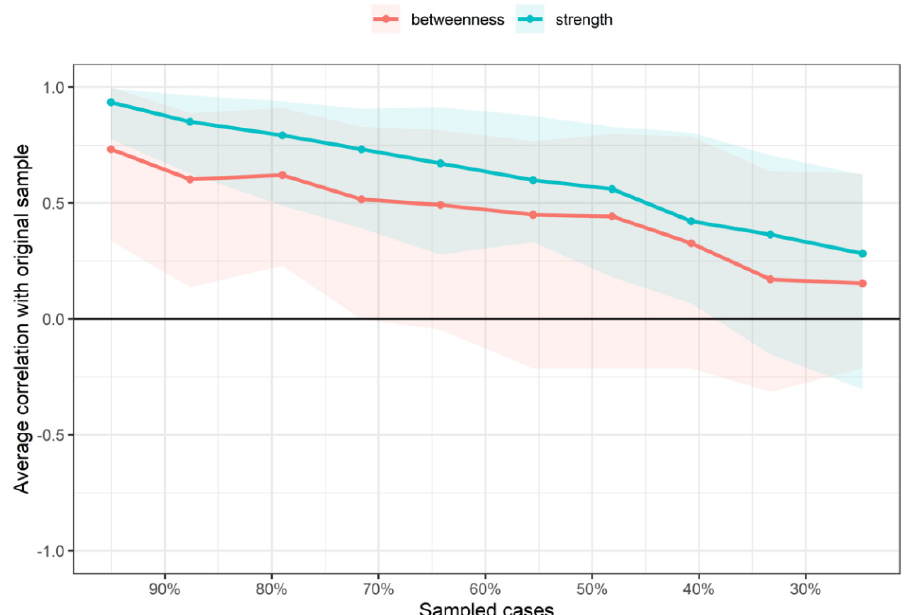
Figure 3. Average correlations between centrality indices of networks sampled with persons dropped and networks built on the entire input dataset. Lines indicate the means and areas indicate the range from the 2.5th quantile to the 97.5th quantile.